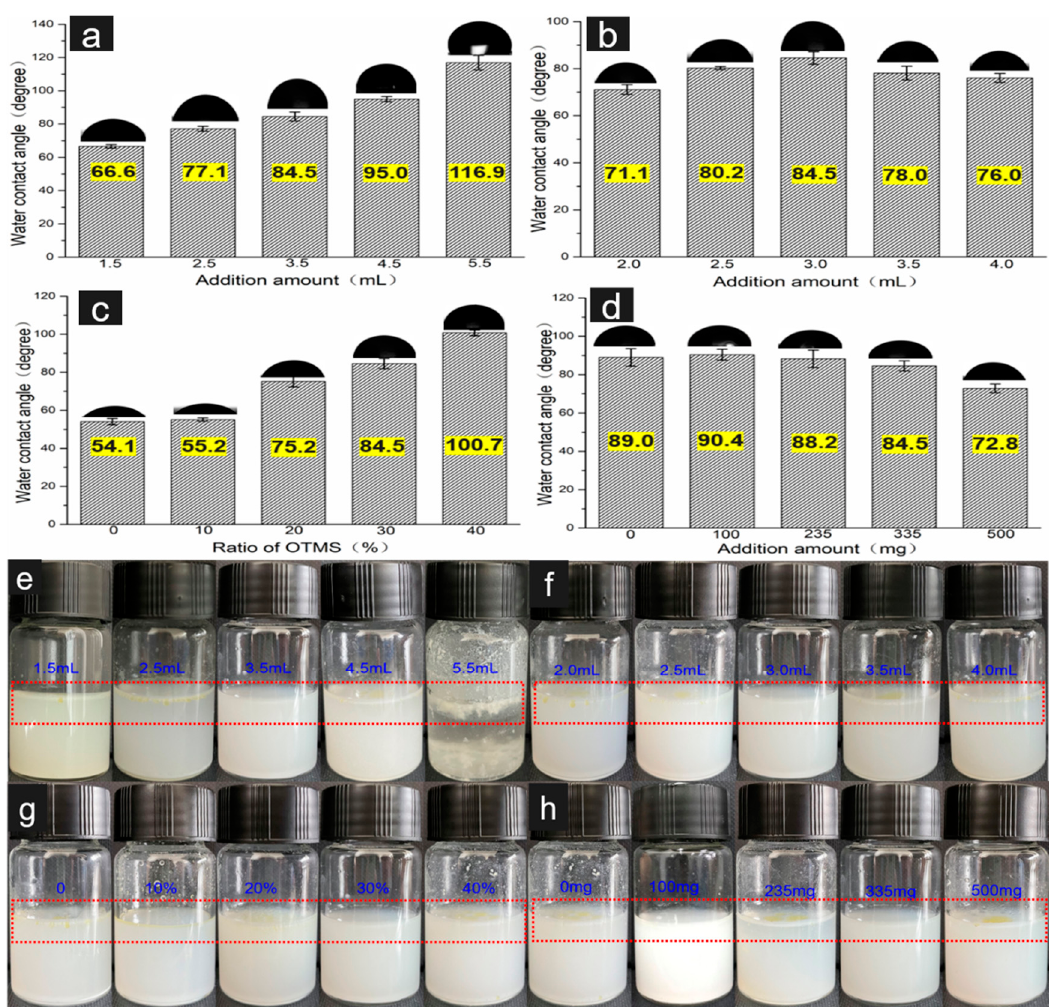
Figure 1. The effects of different factors on the water contact angle of organic hollow mesoporous silica and its loading capacity to SEO ( a , e ) The additional amount of silicon source deposited on the shell were 1.5 mL, 2.5 mL, 3.5 mL, 4.5 mL and 5.5 mL from left to right. ( b , f ) The ammonia hydroxide solution addition were 2.0 mL, 2.5 mL, 3 mL, 3.5 mL and 4 mL from left to right. ( c , g ) The ratio of OTMS to silicon sources deposited on the shell were 0, 10%, 20%, 30% and 40% ( v/v ) from left to right. ( d , h ) The additional amount of CTAC were 0, 100 mg, 235 mg, 335 mg and 500 mg from left to